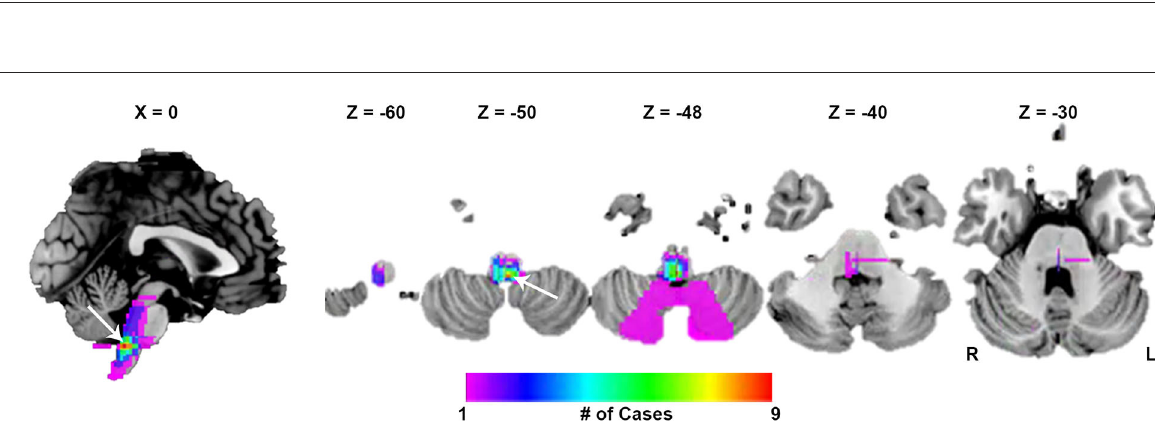
FIGURE2 Lesion overlap maps. The peak overlap was 9/27 (33.3%) and occurred in the dorsal medulla (white